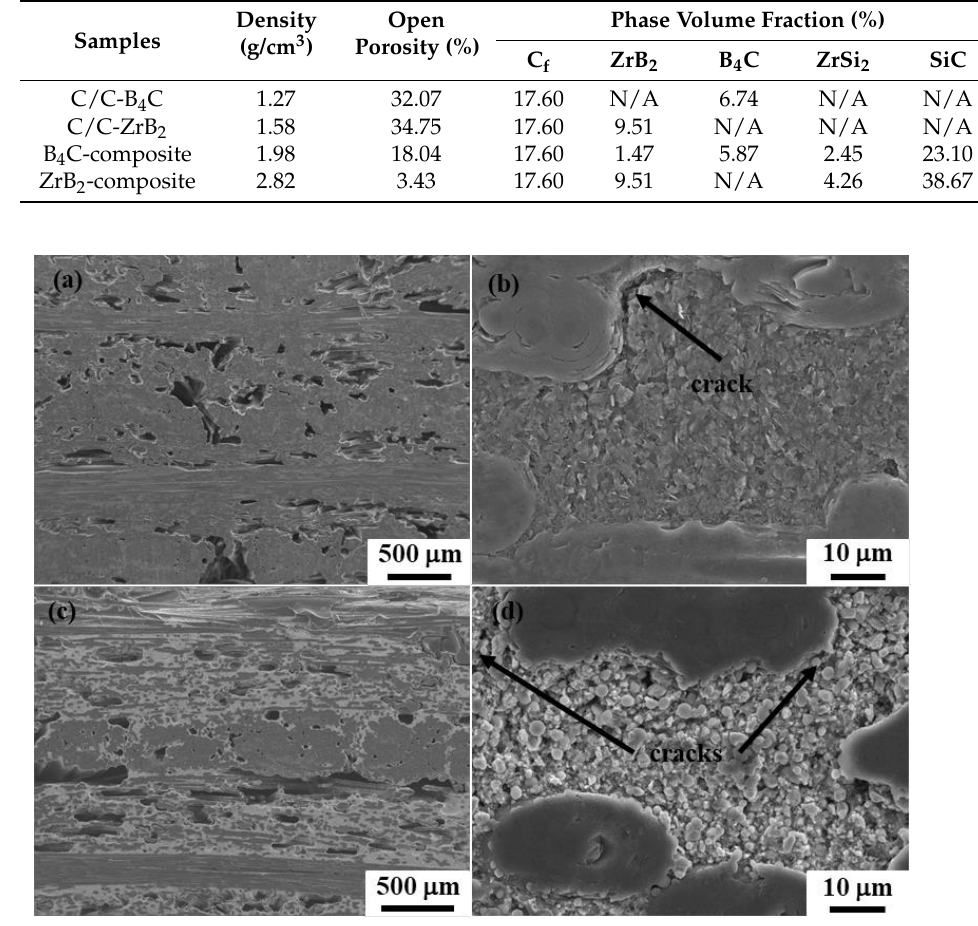
Figure 2. SEM images of several used preforms: polished cross-sections of porous C/C–B 4 C ( a ) and C/C–ZrB 2 preforms ( c ); the B 4 C–C ( b ) and ZrB 2 –C mixture ( d ) between carbon fibers.